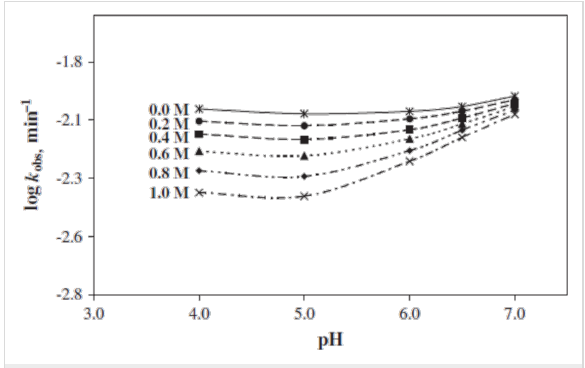
Figure 8: log k obs –pH profiles for the photolysis of RF (5 × 10 − 5 M) in 0.2–1.0 M citrate buffer. Experimental conditions are the same as in Figure 6. Reproduced with permission from [31]. Copyright 2011 Else-